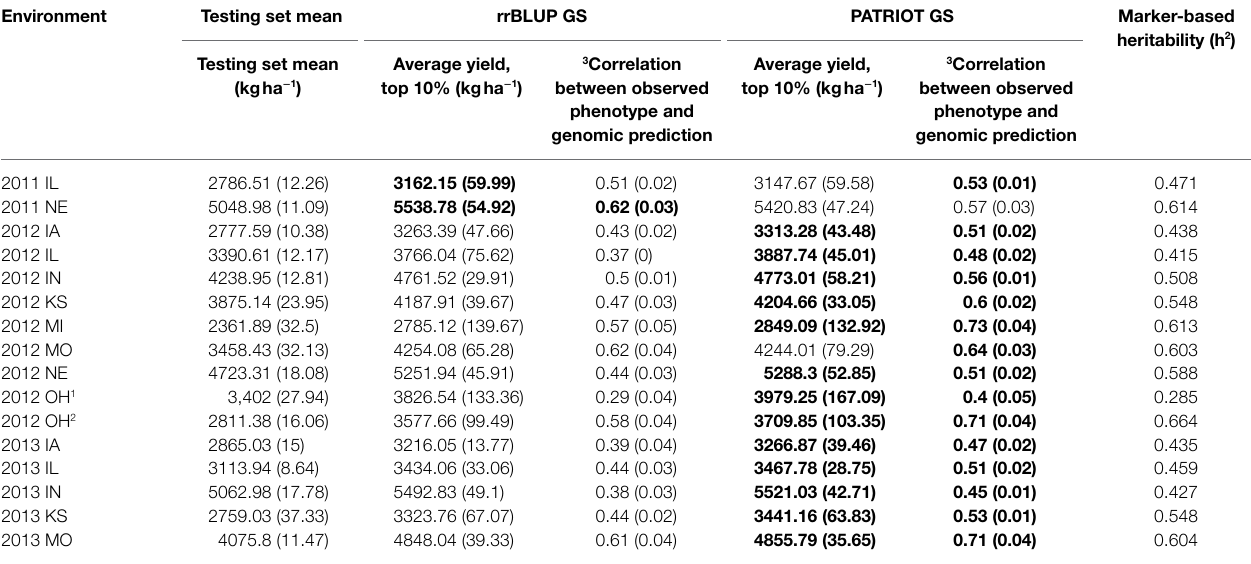
TABLE 3 | Comparison of the effectiveness of genomic selection methods rrBLUP GS and PATRIOT GS for yield. Environment Testing set mean